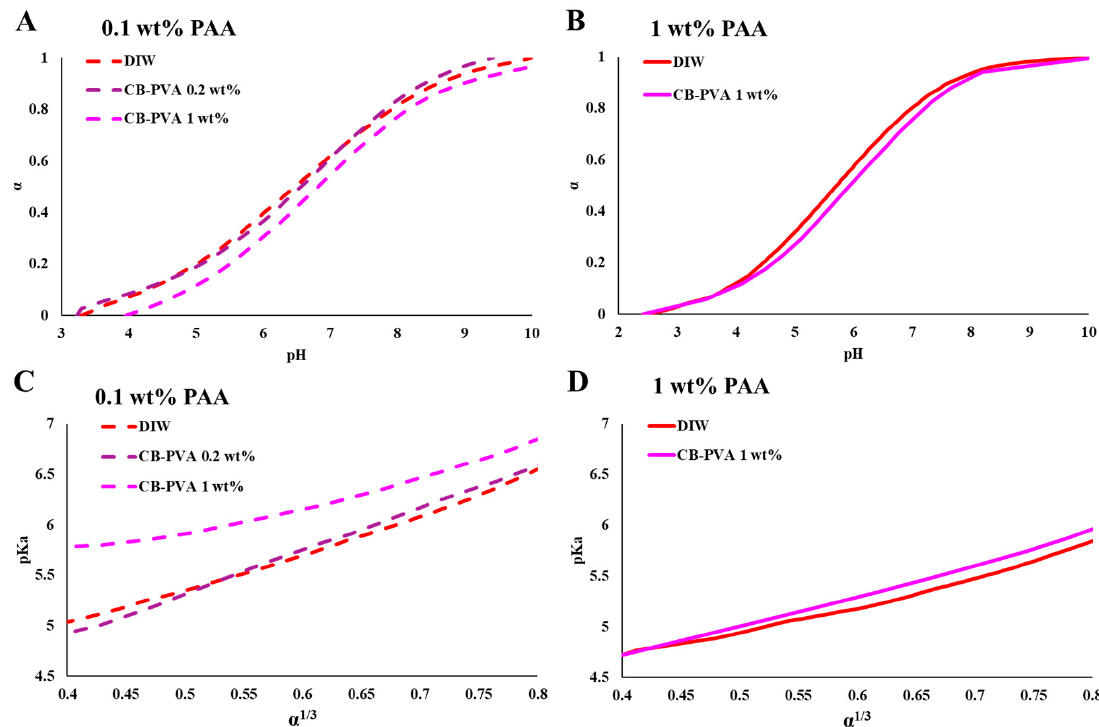
Figure 5. Titration curves presenting the degree of ionization ( α ) as a function of pH for PAA 100 kDa in dispersions of CB-PVA: ( A ) 0.1 wt% PAA, ( B ) 1 wt% PAA, ( C ) pK a as a function of α 1/3 in PAA (0.1 wt%) in CB-PVA dispersions, and ( D ) pK a as a function of α 1/3 in PAA (1 wt%) in CB-PVA dispersions.